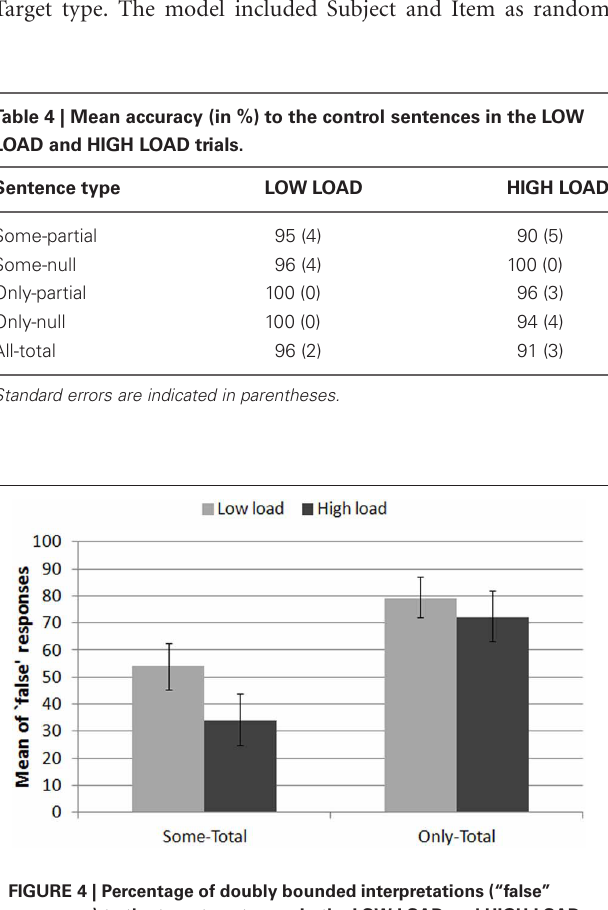
FIGURE 4 | Percentage of doubly bounded interpretations (“false” responses) to the target sentences in the LOW LOAD and HIGH LOAD trials. Error bars are 95% confidence intervals estimated from binomial